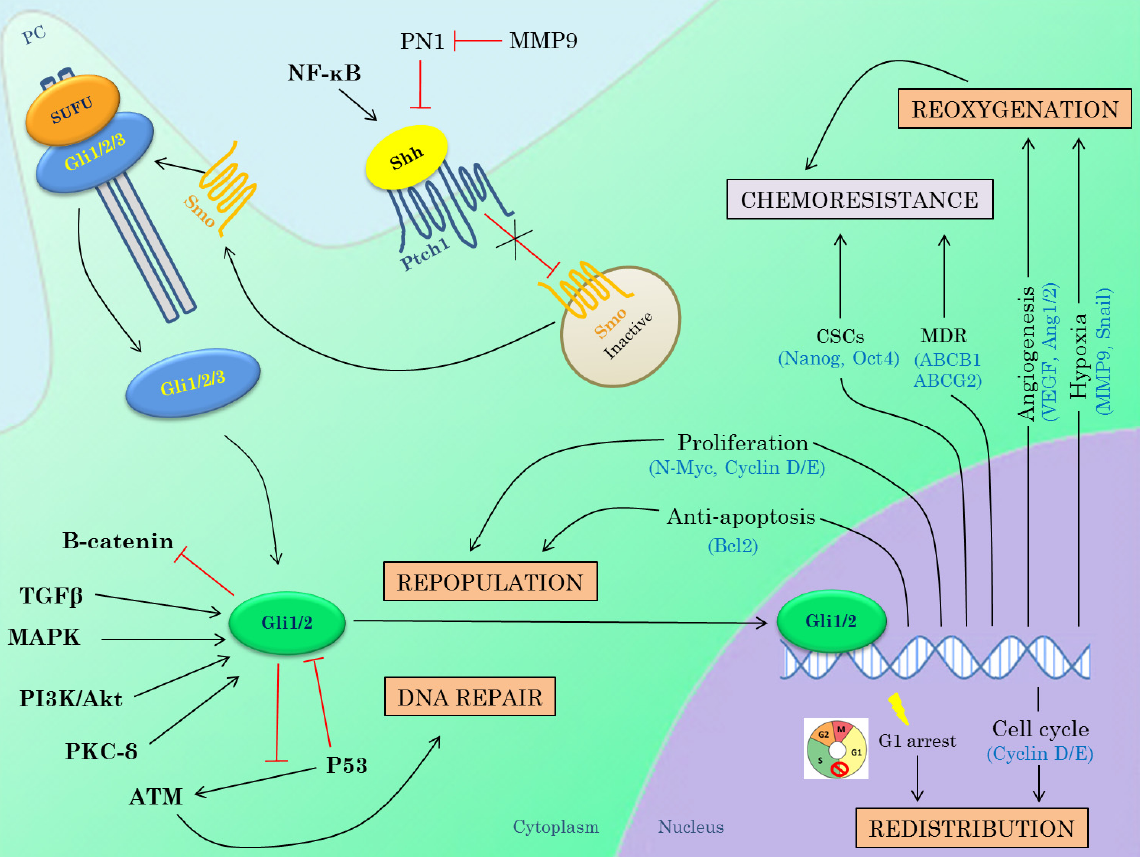
Figure 2. Schematic overview of Hedgehog signaling and rationale for combination therapy with (chemo)radiotherapy. Upon Sonic Hedgehog (Shh) ligand binding to its receptor Patched (Ptch1) 1, the repression of Smoothened (Smo) is relieved, resulting in the movement of Smo from the intracellular vesicles to the primary cilium. Smo becomes activated and promotes the activation of the Gli proteins (Gli1/2) that enter the nucleus and promote transcription of the target genes (canonical pathway activation). The Gli transcription factors can also become activated by means of non-canonical pathway activation due to significant crosstalk with other important pathways such as the PI3K-Akt, KRAS, PKC- δ and TGF β pathways. The Hh signaling also has important interactions with Wnt pathway and P53. The response to radiation therapy is determined by the four R’s of radiobiology: repopulation, repair of sublethal DNA damage, redistribution and reoxygenation. Hh signaling can potentially interfere with all these processes and targeting Hh signaling could therefore increase radiosensitivity of tumor cells. Moreover, inhibition of Hh signaling could also improve the response to chemotherapy by targeting multidrug resistance and cancer stems cells in addition to its effects on tumor